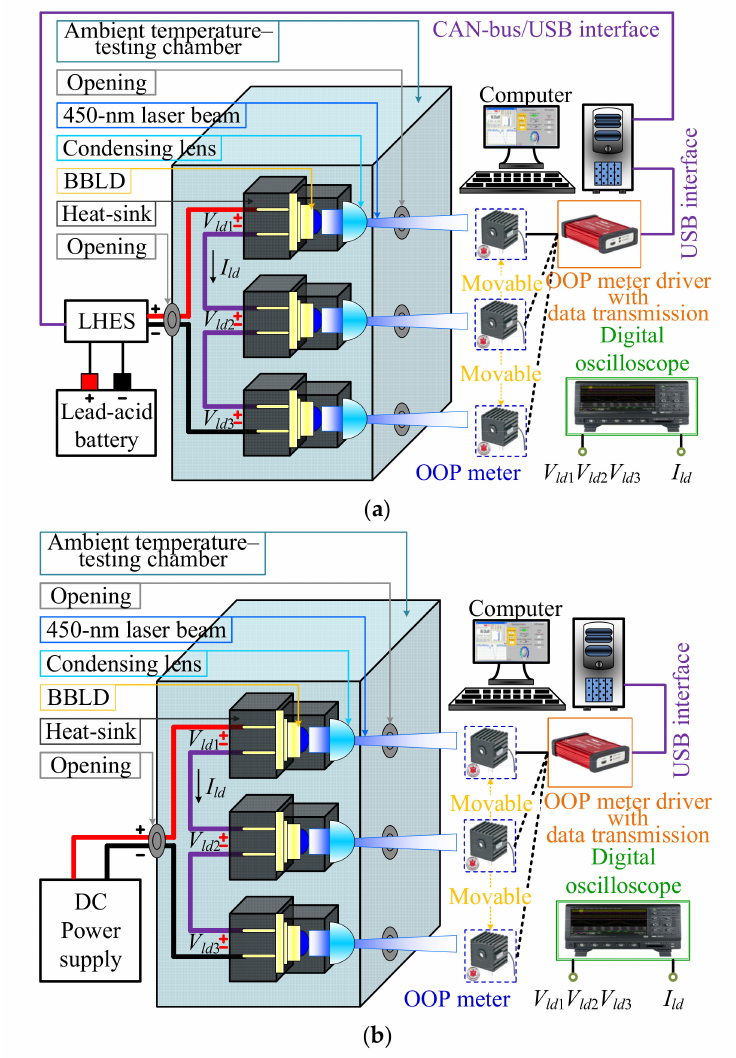
Figure 7. Measurement systems of blue-beam laser diodes (BBLD electrical and optical characteristics. ( a ) PDCM. ( b ) Average current